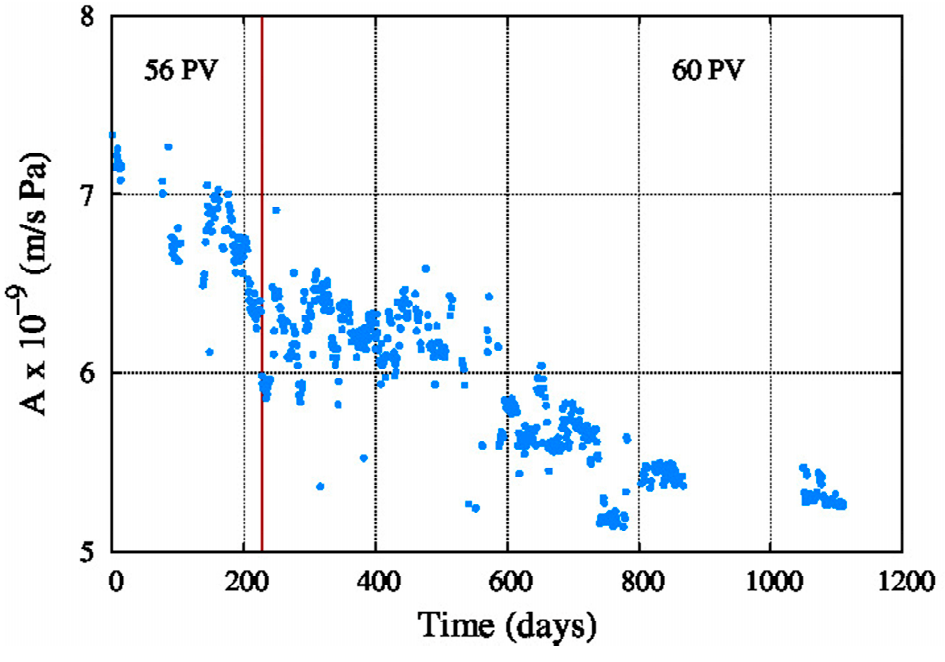
Figure 9. Average water permeability coefficient.